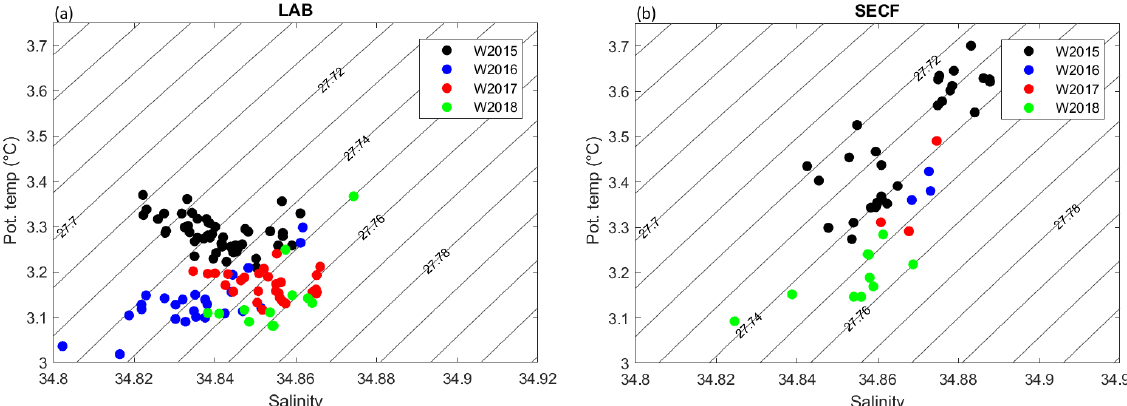
Figure 3. TS diagrams in the mixed layer for profiles with an MLD deeper than 700m during the winters of 2015, 2016, 2017 and 2018 for (a) the Labrador Sea and (b) SECF. The properties of the mixed layers were estimated as the vertical means between 200m and the MLD.